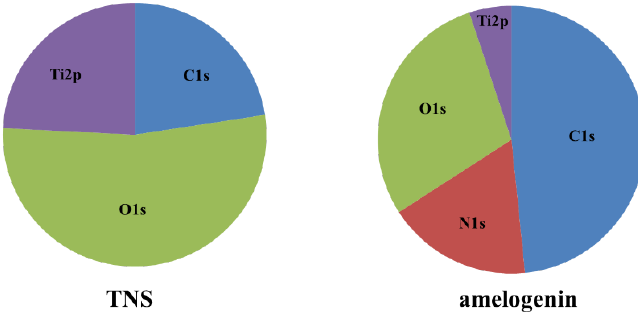
Figure 3. Wide scan of the test and control groups.